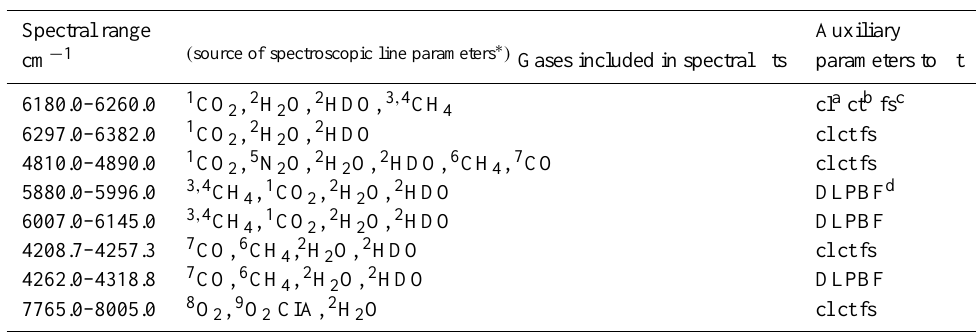
Table 1. Spectral range, species that have spectral signatures within the spectral range, and sources of spectroscopic parameters used in spectral